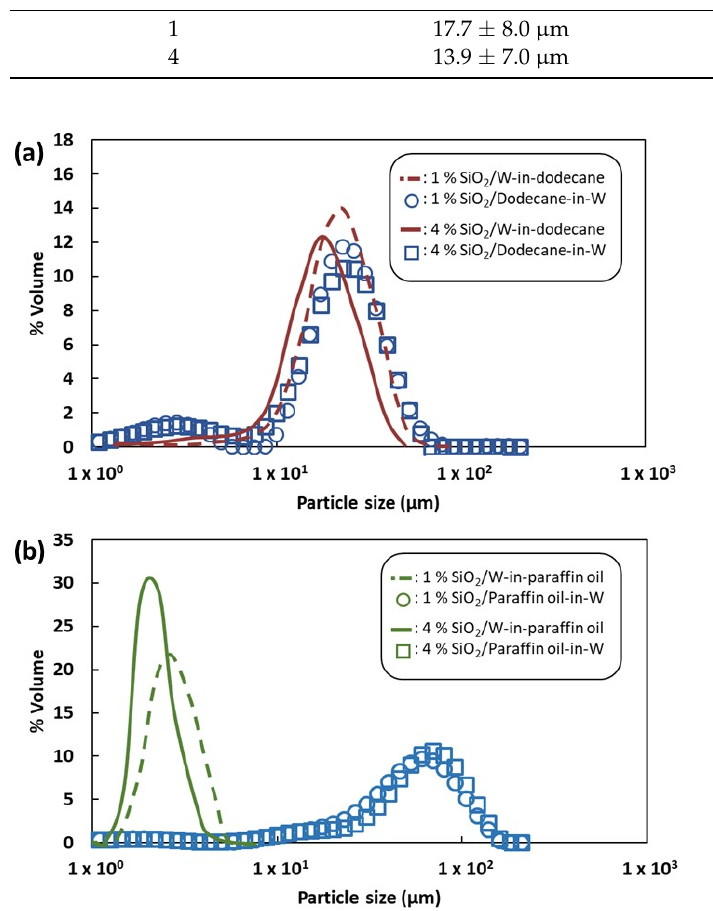
Table 1. Average droplet diameter of reverse W/O and direct O/W emulsions prepared with water and dodecane. Silica Content (wt.%)